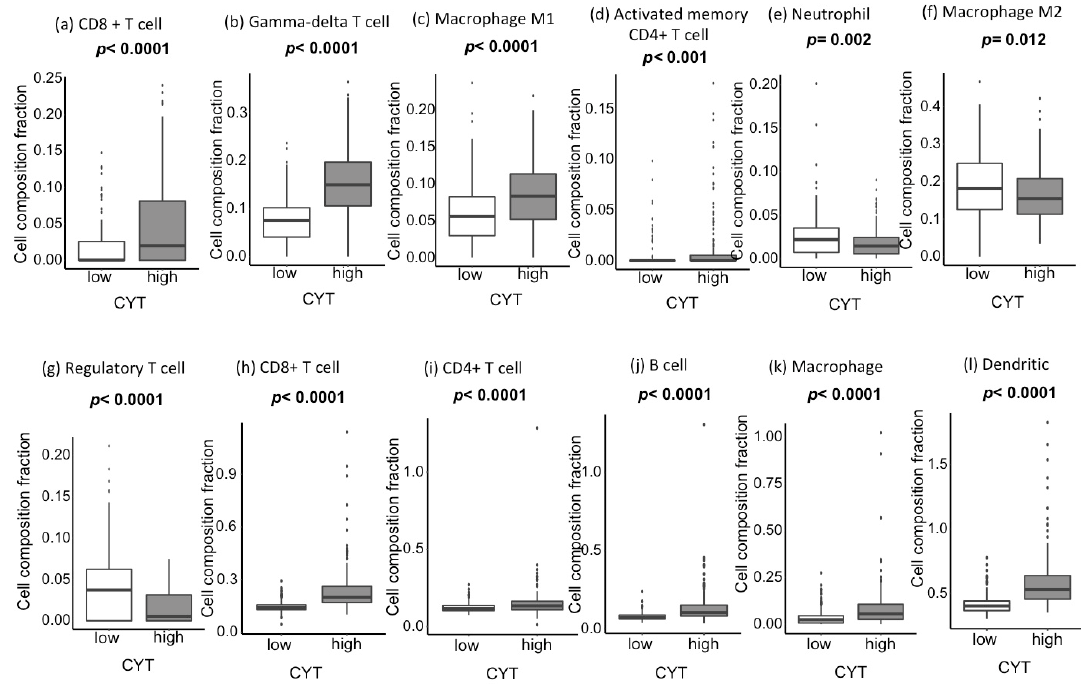
Figure 2. Association between the CYT and tumor-infiltrating immune cell composition in CIBERSORT and Tumor Immune Estimation Resource (TIMER). ( a – g ) CYT-high (185 patients) vs. CYT-low (186 patients) in CIBERSORT. ( a ) CD8+ T-cell ( p < 0.0001), ( b ) gamma-delta T-cell ( p <